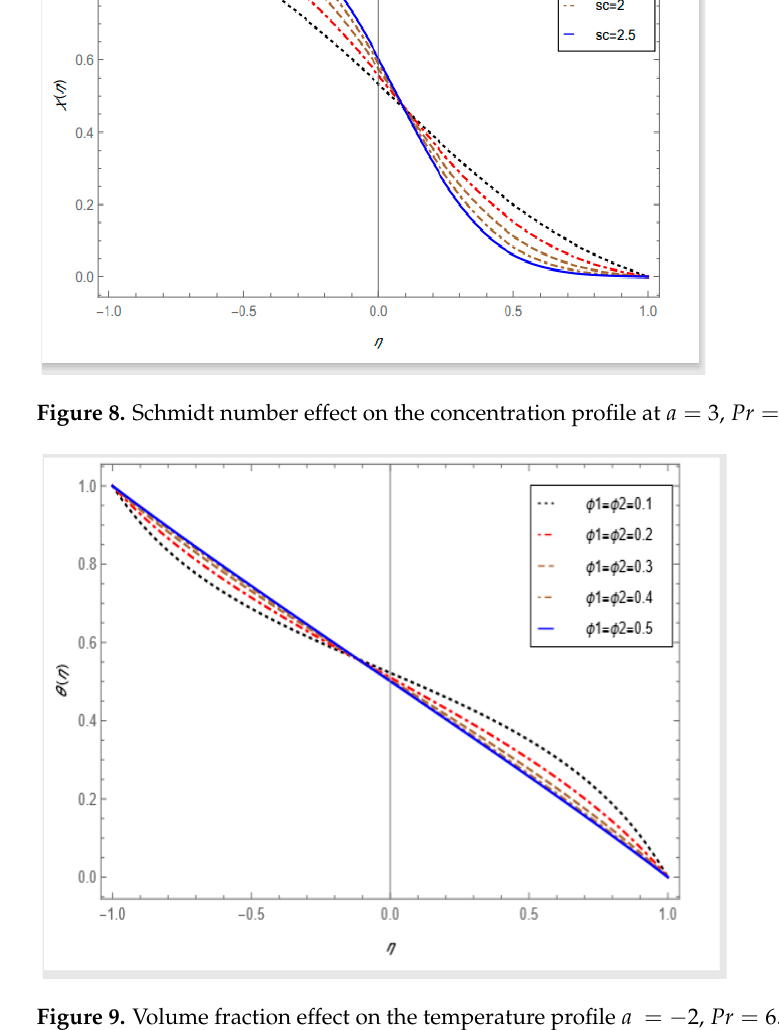
Figure 9. Volume fraction effect on the temperature profile a = − 2, Pr = 6.2, R e = −